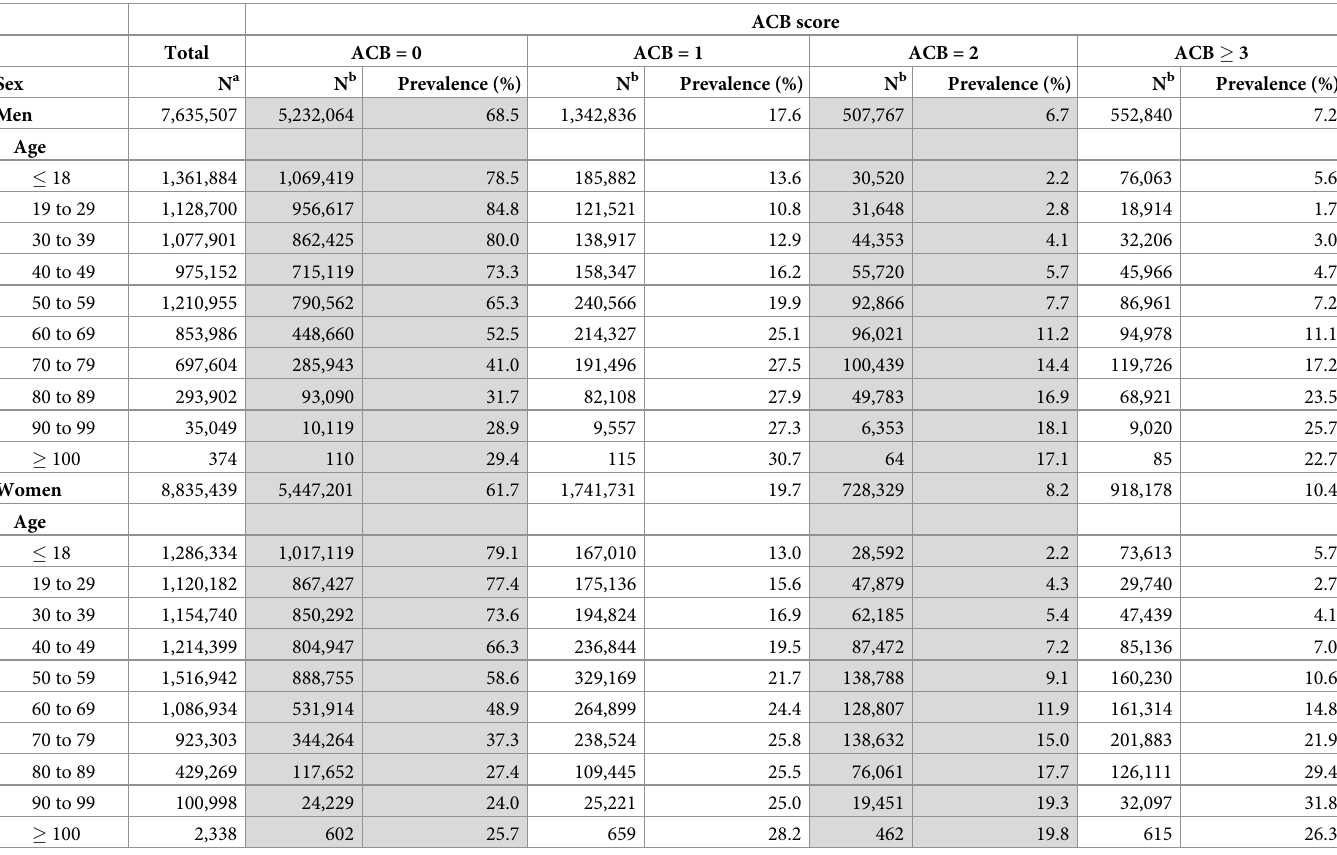
Table 1. Number and period prevalence of persons with and without anticholinergic burden measured through the Anticholinergic Cognitive Burden (ACB) scale during the observation period (2016), by sex and